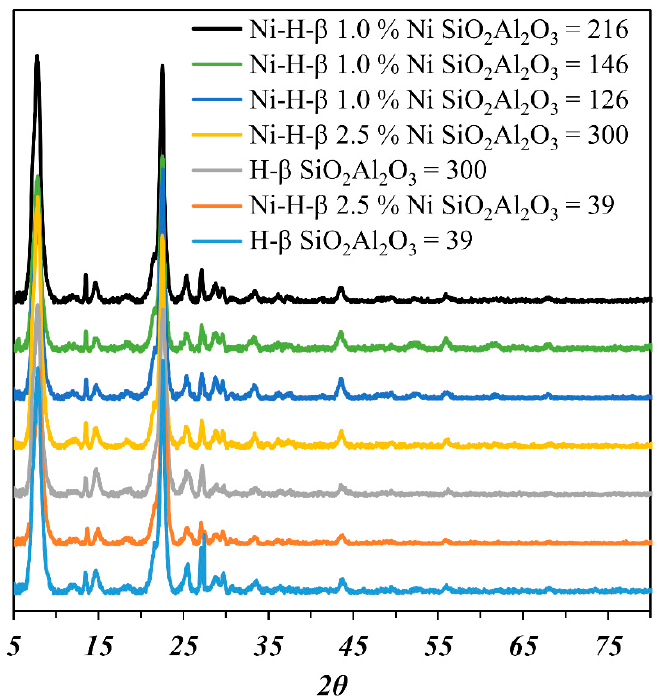
Figure 6. X-ray powder diffraction of the pristine H-Beta support and Ni-H-Beta catalysts at different SiO 2 /Al 2 O 3 ratios and nickel loadings.